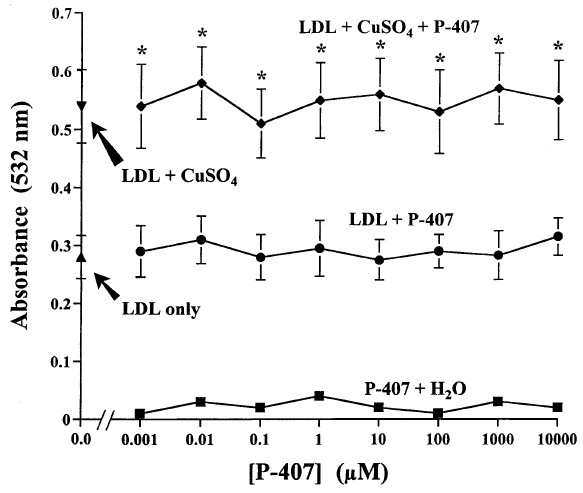
FIG. 4. The effect of P-407 on the oxidation of human low- density lipoprotein (LDL) invitro. ( ' ) LDL alone, ( % ) LDL (cid:2) / 10 mM CuSO 4 , ( j ) P-407 (cid:2) / H 2 O, ( m ) LDL (cid:2) / P-407, and ( " ) LDL (cid:2) / CuSO 4 (cid:2) / P-407. All data points represent the mean value 9 / standard deviation (n (cid:4) / 4). * Significant (p B / 0.05) increase in the absorbance values relative to mean values for LDL alone and LDL (cid:2) / P-407.